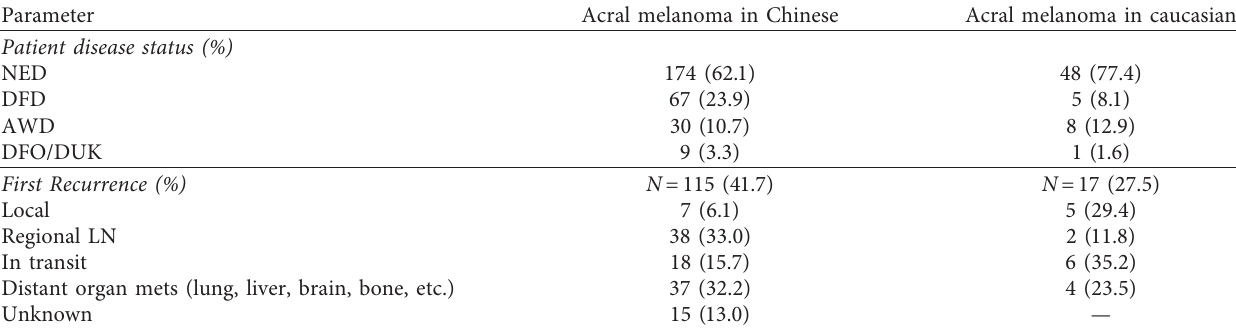
Table 2: Patient disease status and recurrence of AM patients in Chinese and